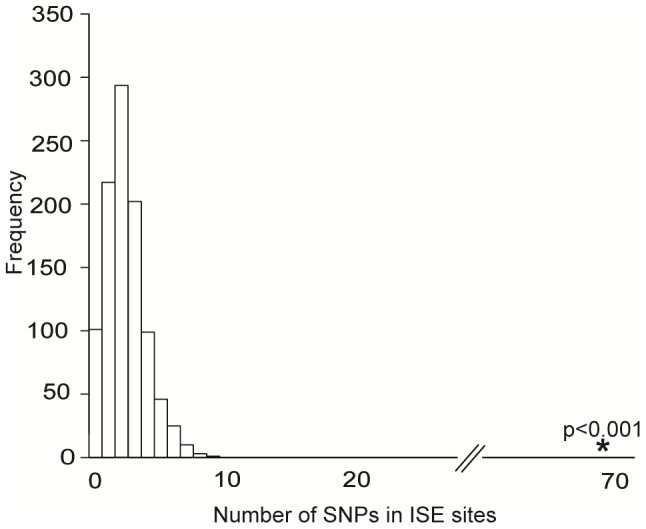
Enrichment of Exon Skipping–Associated ISE SNPs among cis-eQTL SNPs.Predicted exon-skipping ISE SNPs are enriched among cis-eQTL SNPs (p<0.001). The distribution of the number of predicted exon-skipping ISE SNPs observed for each of 1,000 draws of 68 SNPs from bins matched for minor allele frequency (MAF, CEU) to the cis-eQTL SNPs is shown in the bar graphs, with the actual number of 68 predicted exon-skipping ISE SNPs observed in the cis-eQTL SNPs shown as a solid asterisk.